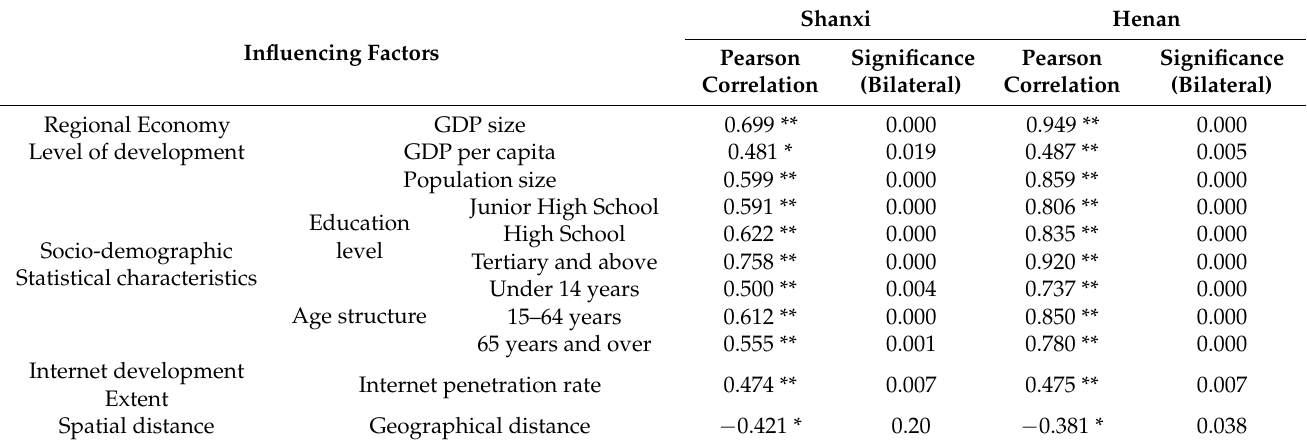
Table 3. Analysis of influencing factors of per capita internet attention. Influencing Factors